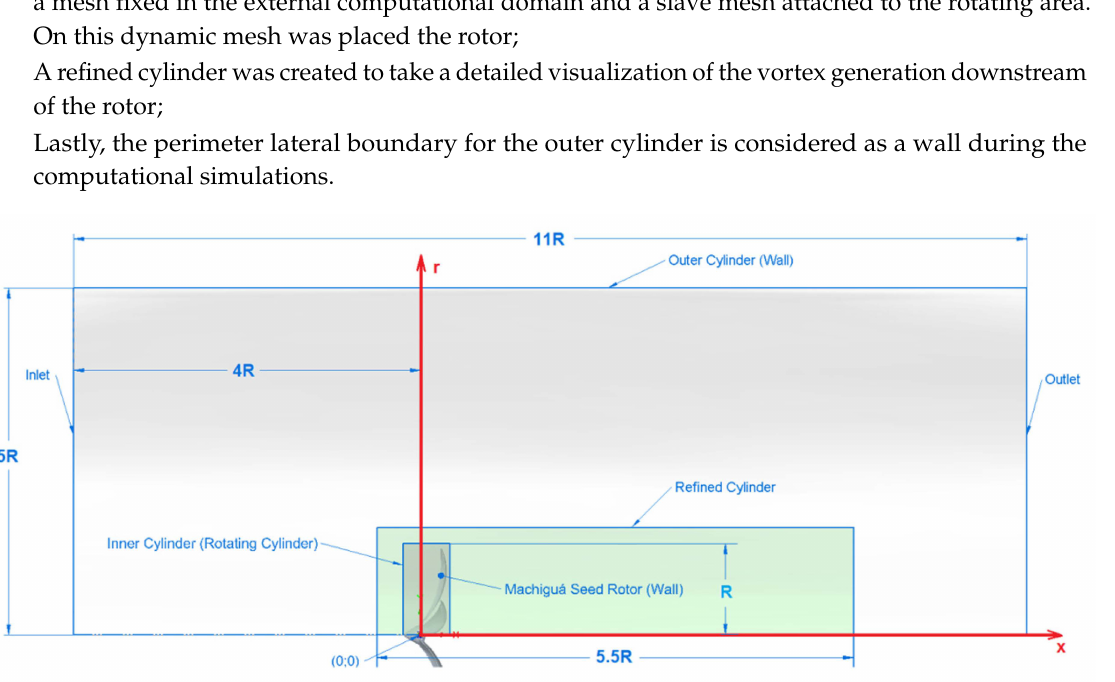
Figure 8. Schematic of Computational Domain (units in meters), the symmetry line does not mean symmetry